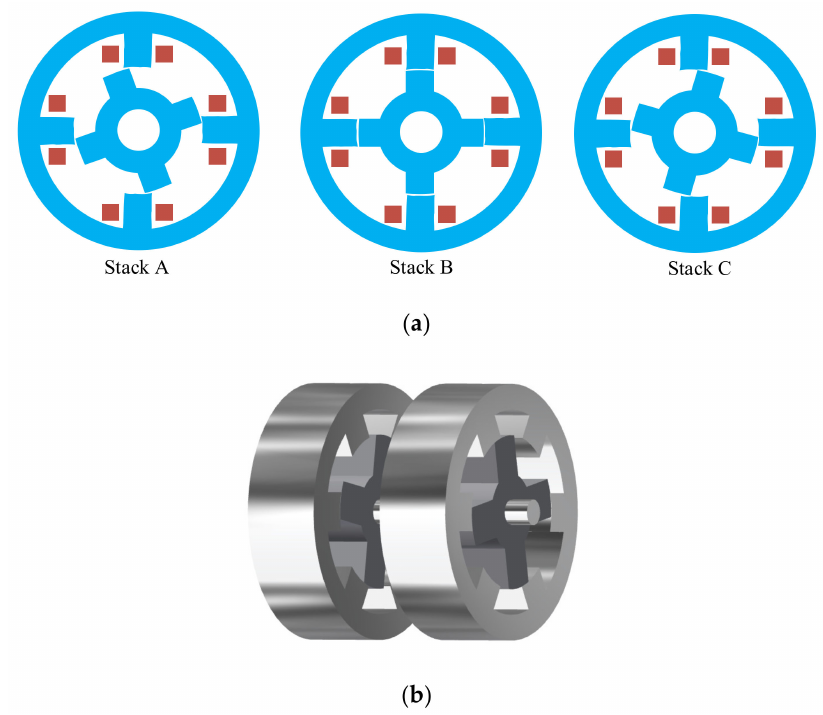
Figure 4. Multi-stack conventional SRMs: ( a ) A three-stack conventional SRM; ( b ) A two-stack conventional